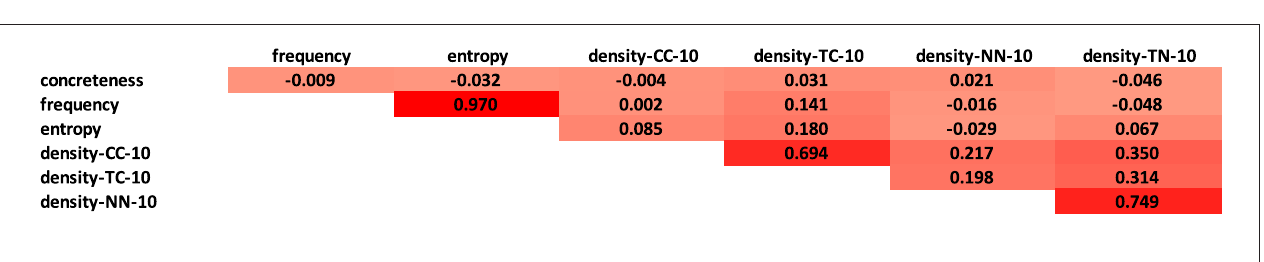
FIGURE 13 | Spearman’s ρ correlations between verb concreteness measures (N-V-A